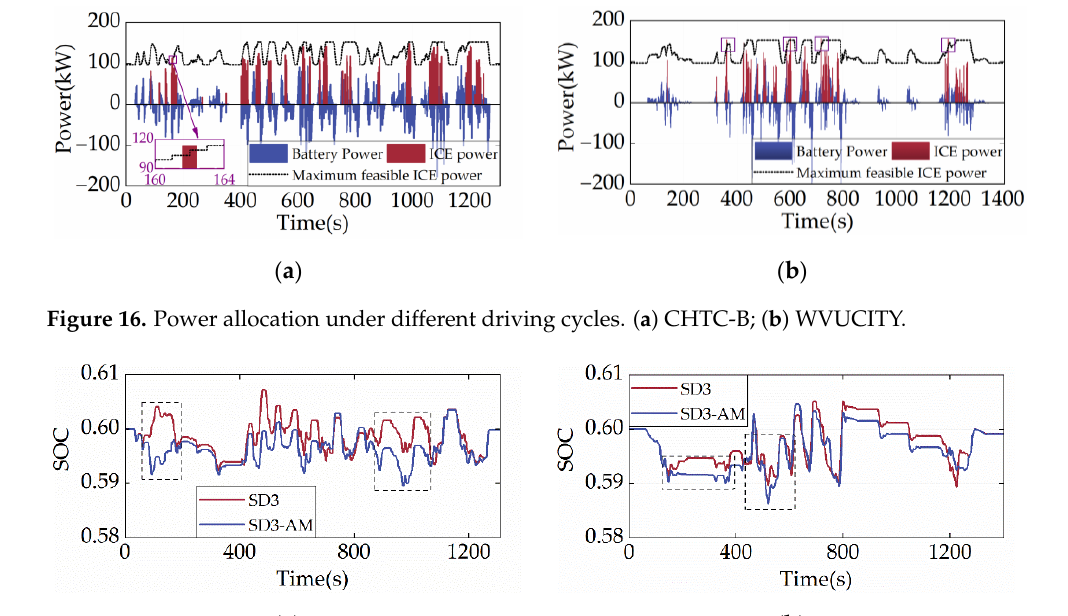
Figure 15. ICE power distribution under different driving cycles. ( a ) CHTC-B; ( b ) WVUCITY.